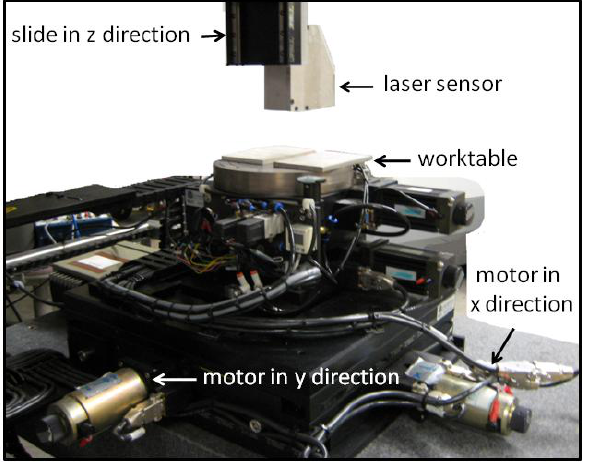
Figure 2. Fabricated laser-based vision sensor mounted on a multi-axis motion